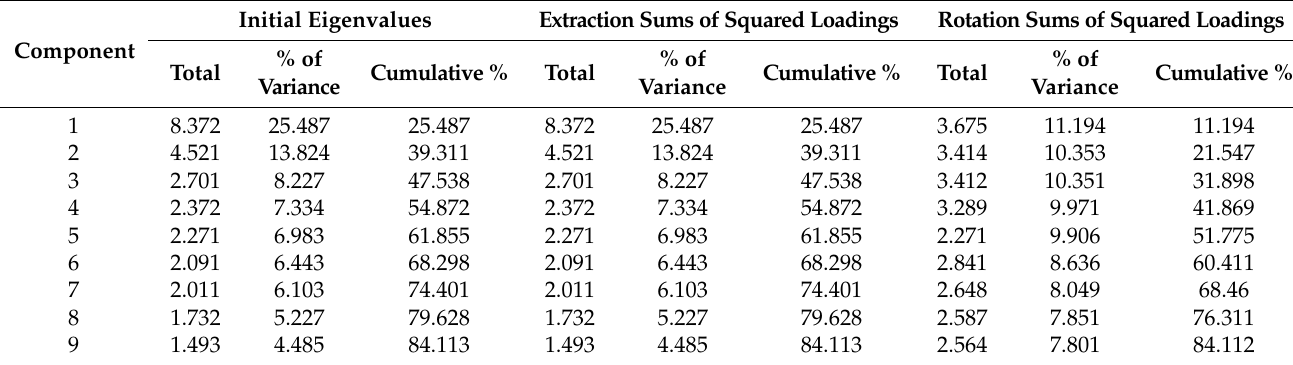
Table 1. Total variance explained using Harman’s single-factor test.